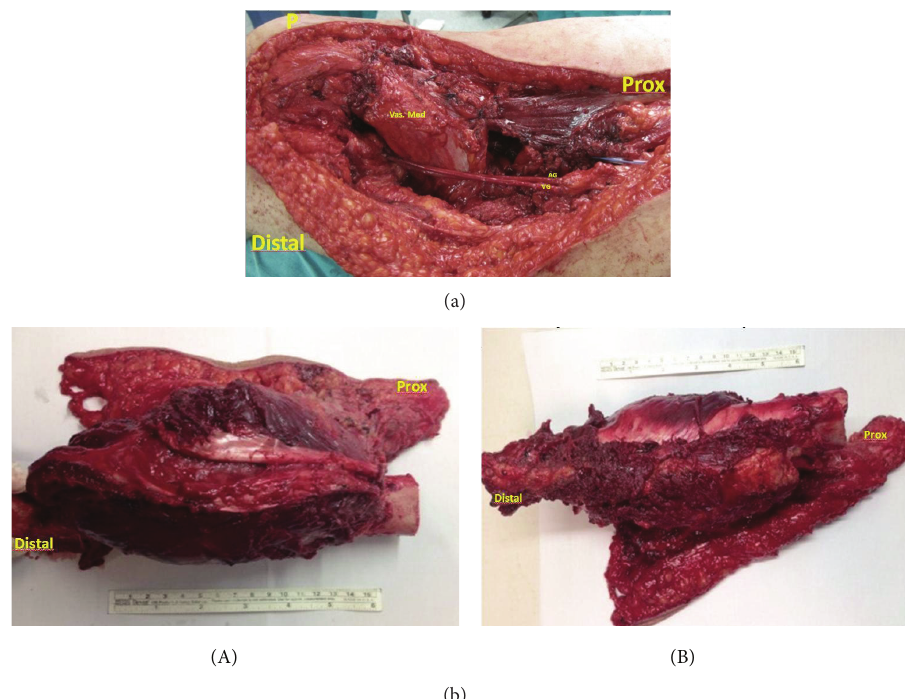
Figure 4: (a) Intraoperative picture demonstrating soft tissue coverage of massive allograft and reconstructed femoral artery and vein using saphenous vein graft (P: patella, Prox: proximal, Vas. Med: vastus medialis muscle, AG: arterial graft, and VG: vein graft). (b) (A, B) The